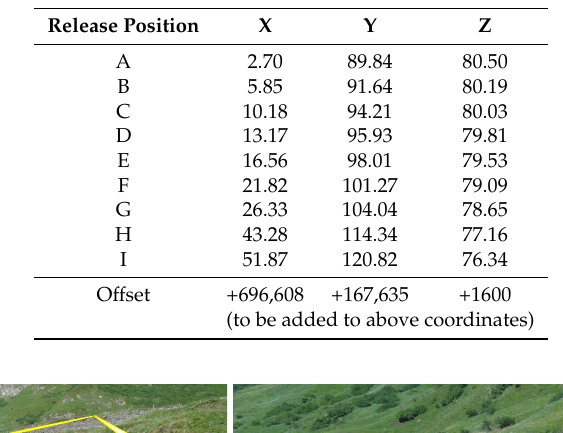
Figure 1. ( a ) Location of the rockfall test site south of the road to the Oberalp Pass (source of backgrounds: map.geo.admin.ch). Red lines represent six profiles of the slope, Figure 2d shows topographical cross-sections of the slope for these six profiles; ( b ) shows the same location as the aerial image. Table 1. Rockfall release positions given in CH-1903 coordinates.